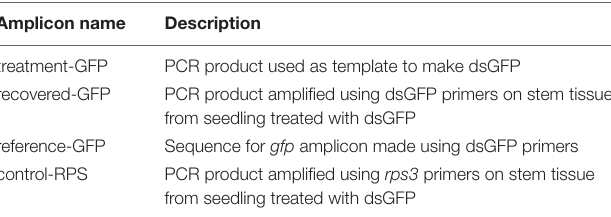
TABLE 2 | Sequenced amplicons from dsRNA synthesis and recovered seedling